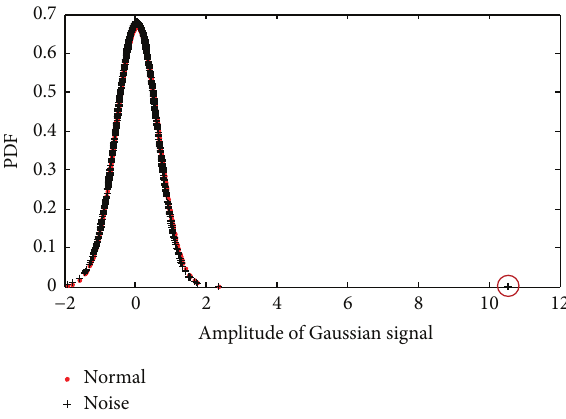
duration of 12 seconds. Wear gears faults of planetary gearbox were implanted in one tooth of ring gear, planet gear, and sun gear, respectively, in order to verify the proposed